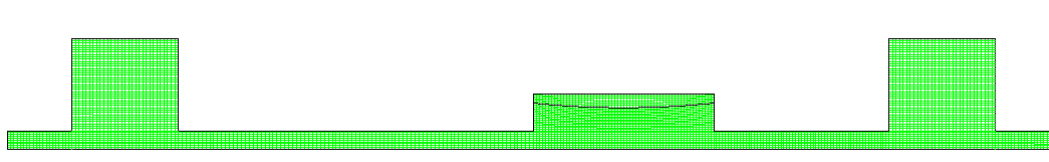
Figure 3. Meshes used for CFD